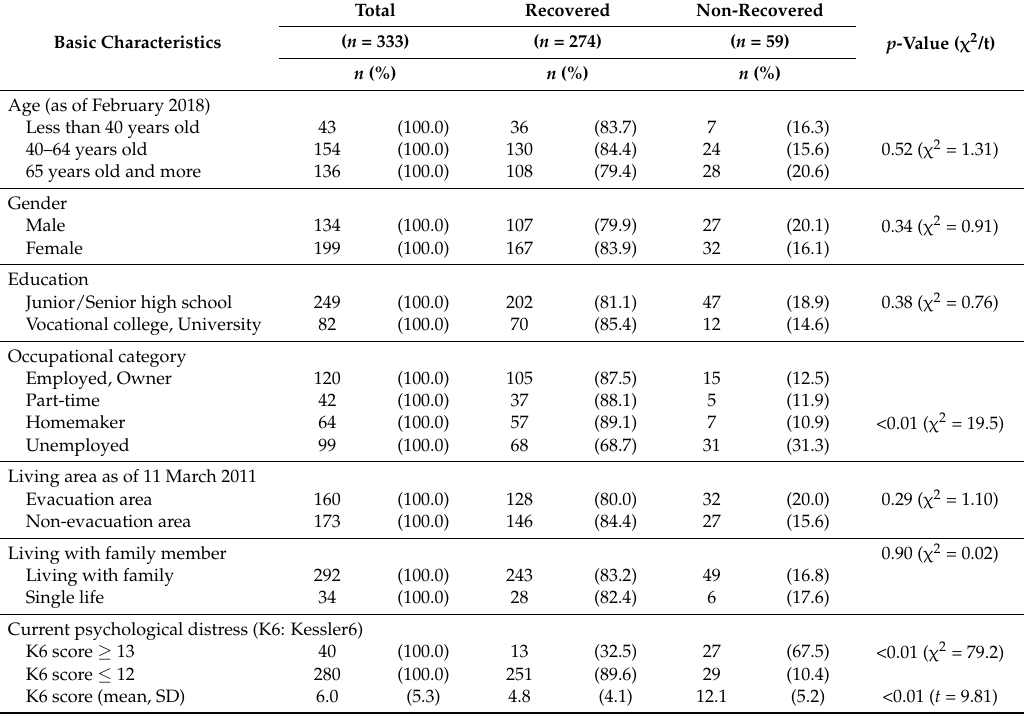
Table 2. Basic characteristics of subjects (Recovered/Non-recovered group).